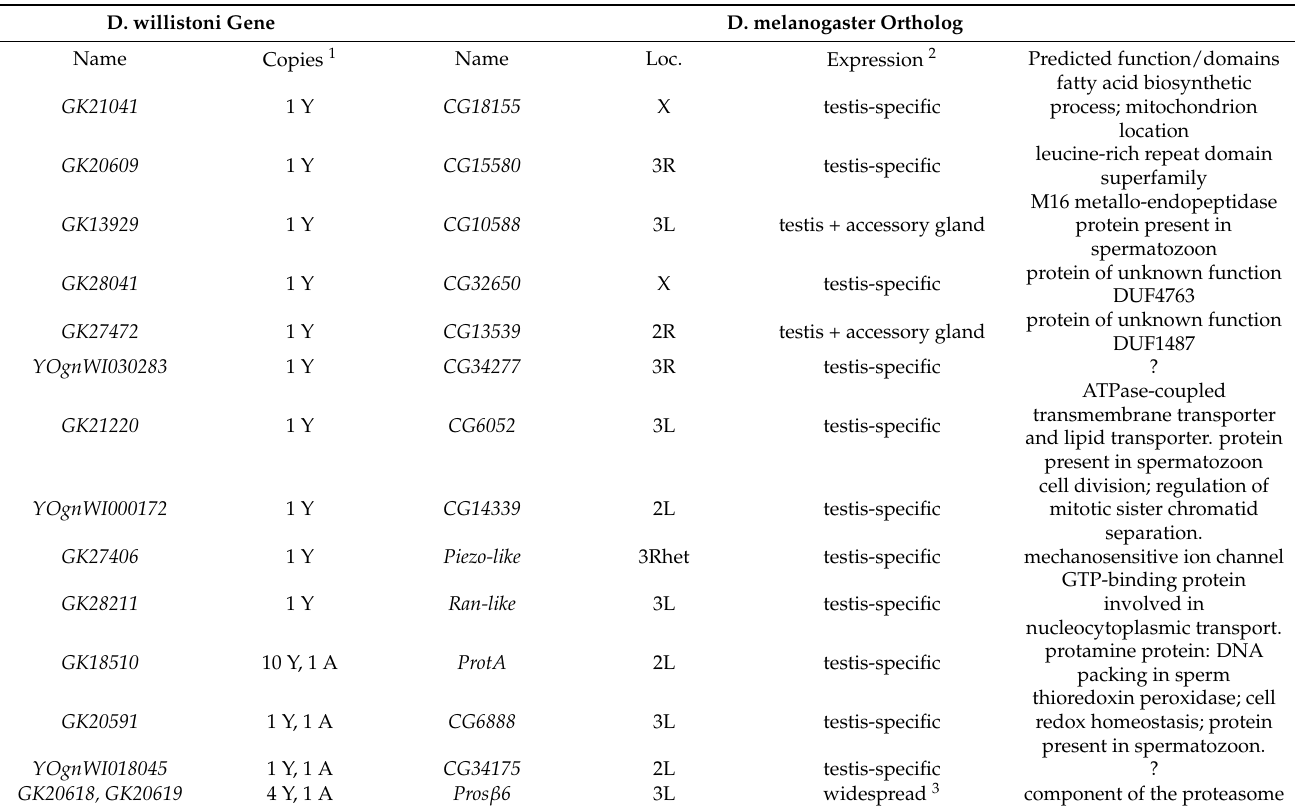
Table 1. D. willistoni Y-linked genes found in this